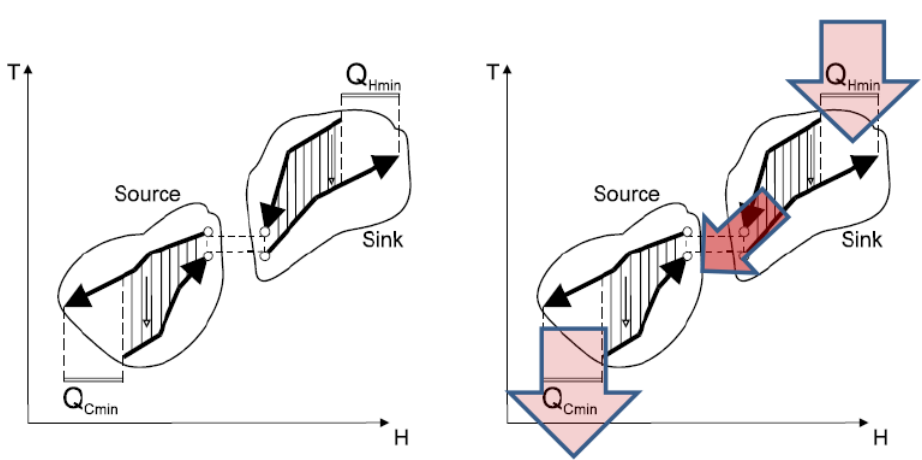
Fig. 31. – Suboptimal heat recovery to be avoided